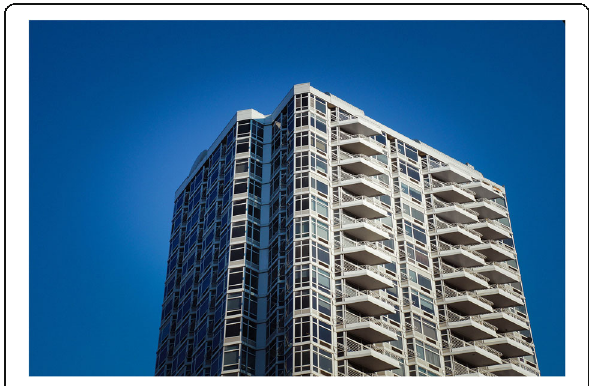
Fig. 2 The Future apartment building at 200 East 32nd Street in Manhattan. Architectural design that appeals primarily to the eye? [Credit Jeffrey Zeldman, and reprinted under